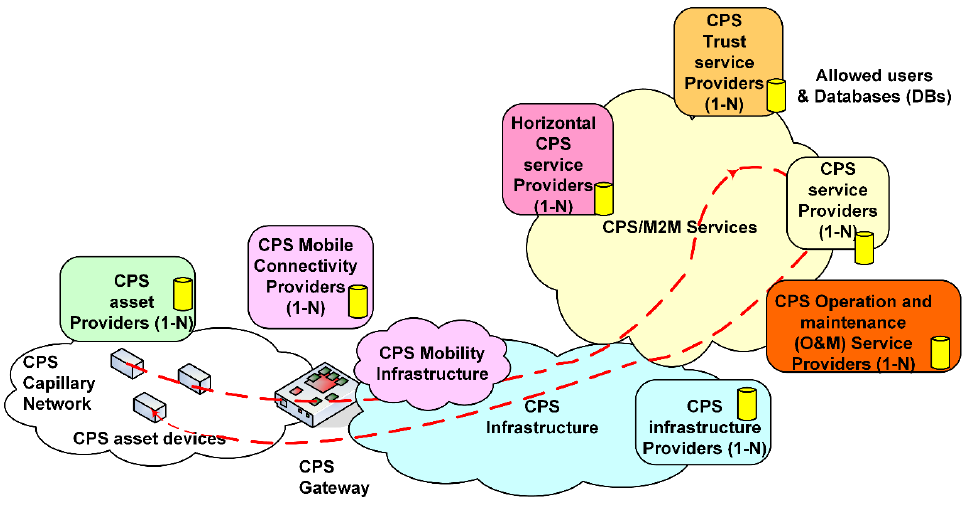
Figure 1. A view of the structure of a cyber-physical system (CPS).